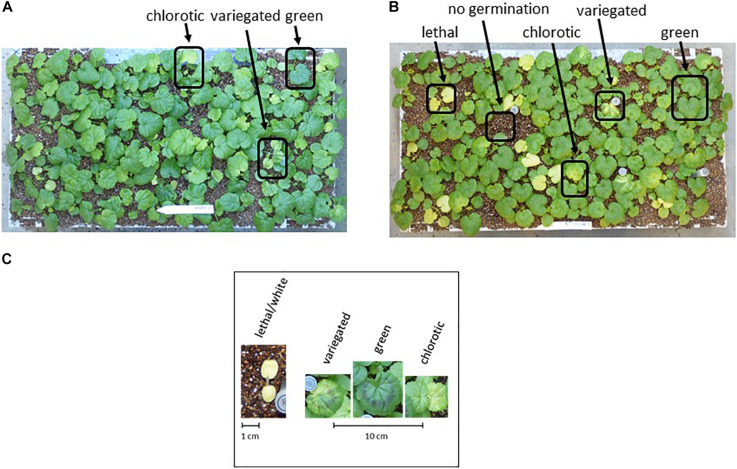
Chlorosis phenotypes. (A) Segregation for chlorosis among progeny in the F2 HORT × FRUT. (B) Segregation for chlorosis in F1 HORT × ZONA. Examples of “green,” “chlorotic” and “variegated” plants are indicated, as well as “lethal” phenotypes and seeds that failed to germinate. (C) Scaled close-up of examples of phenotypes.